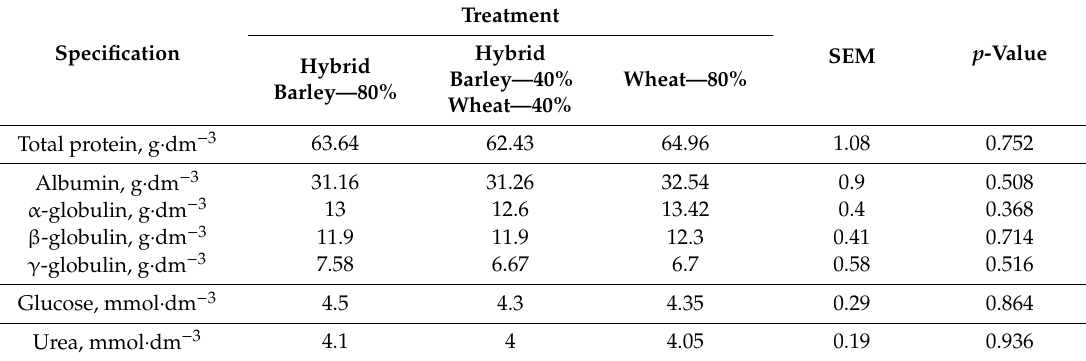
Table 6. Biochemical indicators determined in blood serum of